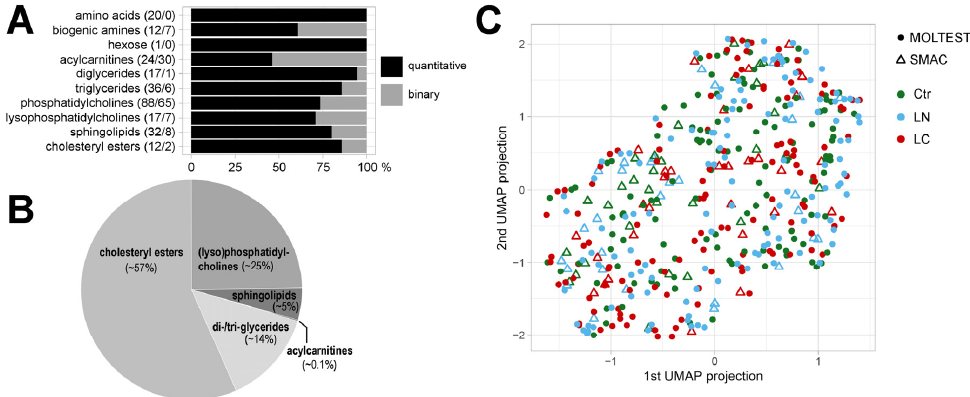
Figure 1. General characterization of the serum metabolite profile: ( A )—numbers of metabolites in different classes used in quantitative and binary analyses (chart shows the relative contribution of compounds used in either type of analysis). ( B )—relative contribution of different classes of lipids to the aggregated concentration of whole detected lipids. ( C )—the global structure of the dataset. Spatial visualization was created using the UMAP data transformation from 385-dimensional metabolic space to 2D view, preserving the structure of the high-dimensional data to explore the potential sample clustering. Samples from MOLTEST and SMAC cohorts are marked with circles and triangles, respectively (Ctr—controls, LN—benign lung nodules, LC—lung